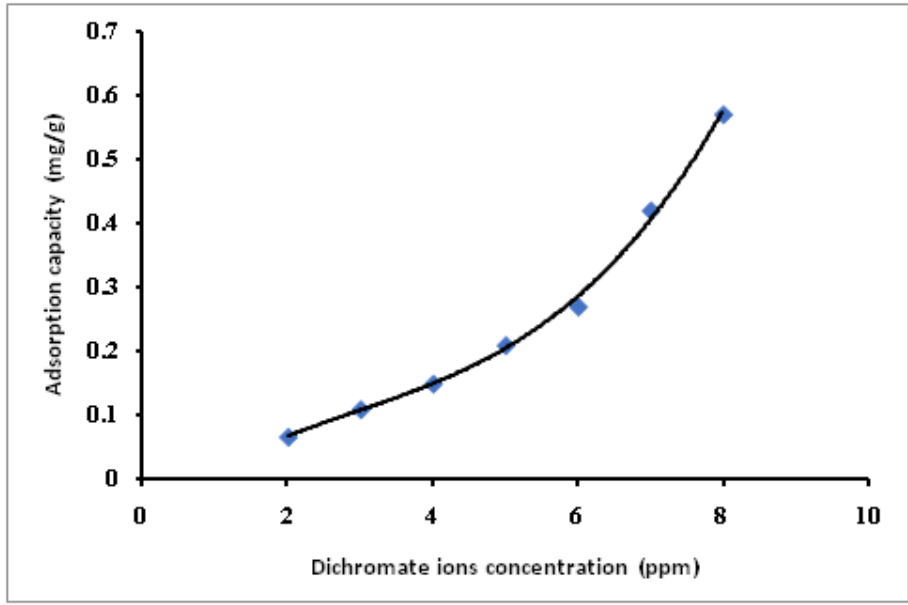
Figure 10. Effect of the dichromate metal ions concentration on MB-SPGMA composite adsorbent adsorption capacity.